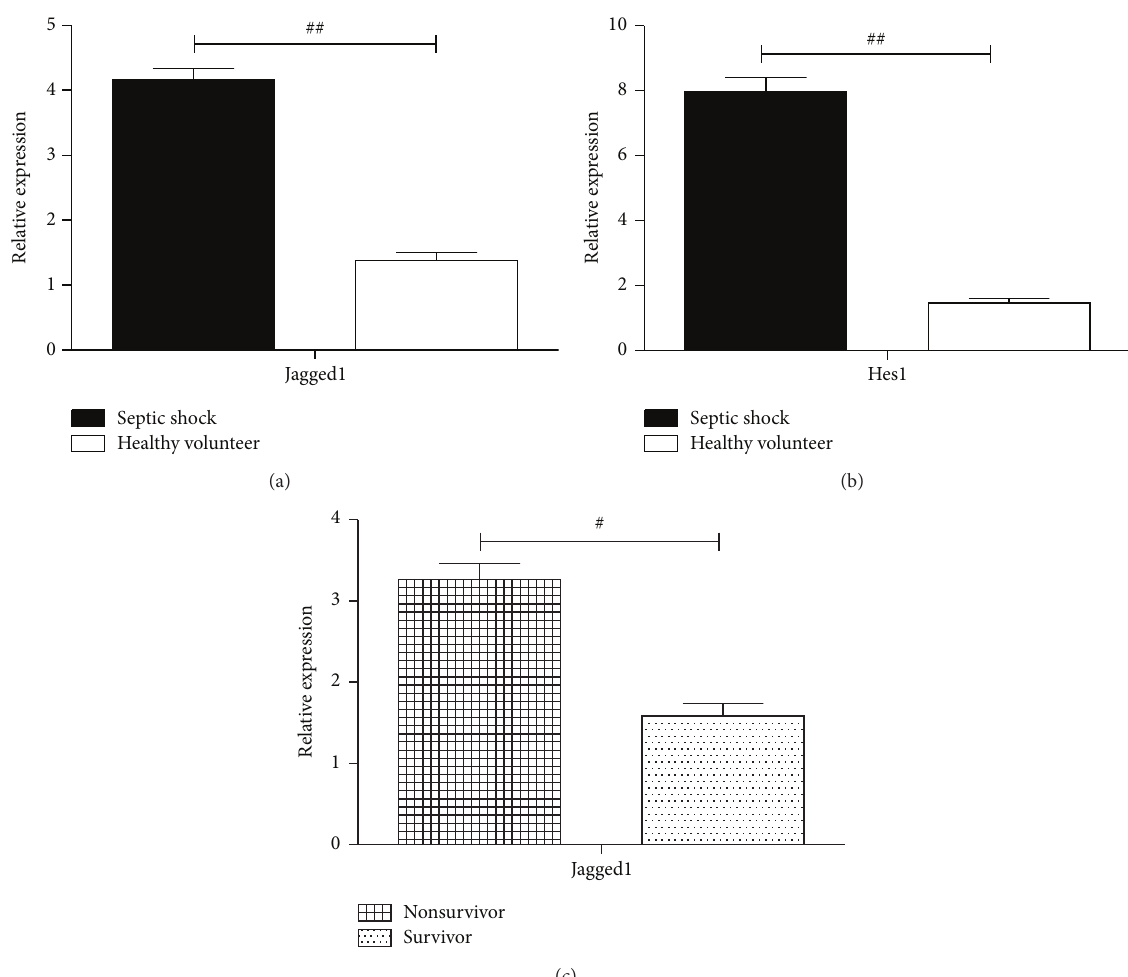
Figure 3: Notch molecules mRNA levels in PBMCs from patients at early stage of septic shock. Total RNA was extracted from PBMCs of patients within 24 hours once septic shock was diagnosed. The mRNA levels of Jagged1 (a) and Hes1 (b) were compared between patients and healthy volunteers. (c) Jagged1 mRNA level was compared between survivors and nonsurvivors with septic shock. Data are normalized to 𝛽 -actin mRNA and presented as 2 −ΔΔ CT . # 𝑃 < 0.05 , ## 𝑃 < 0.01